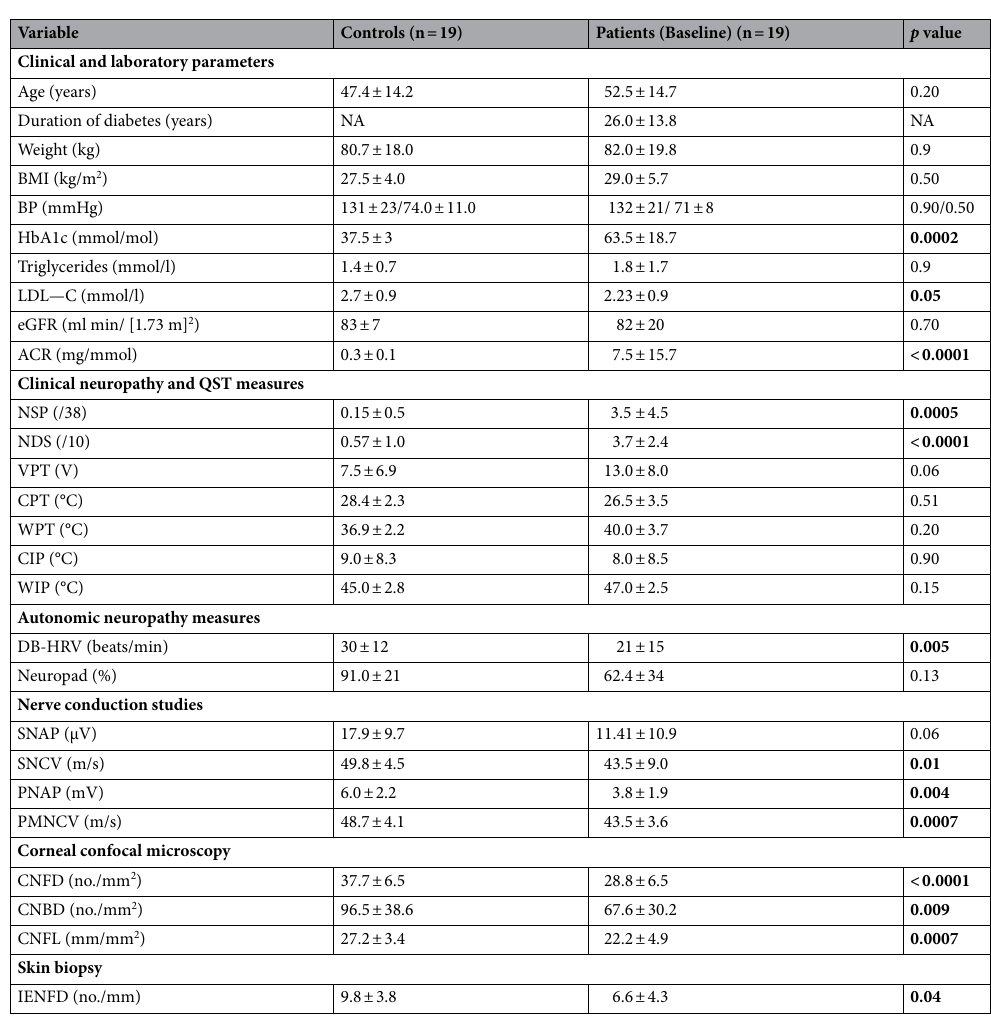
Table 1. Clinical and neuropathy parameters in control subjects and patients at baseline. BMI—body mass index, BP—blood pressure, HbA1c—Glycosylated haemoglobin, eGFR—estimated glomerular filtration rate, ACR—albumin creatinine ratio, LDL-C—low density lipoprotein cholesterol, NSP—neuropathy symptom profile, NDS—neuropathy disability score, VPT—vibration perception threshold, DBHRV—deep